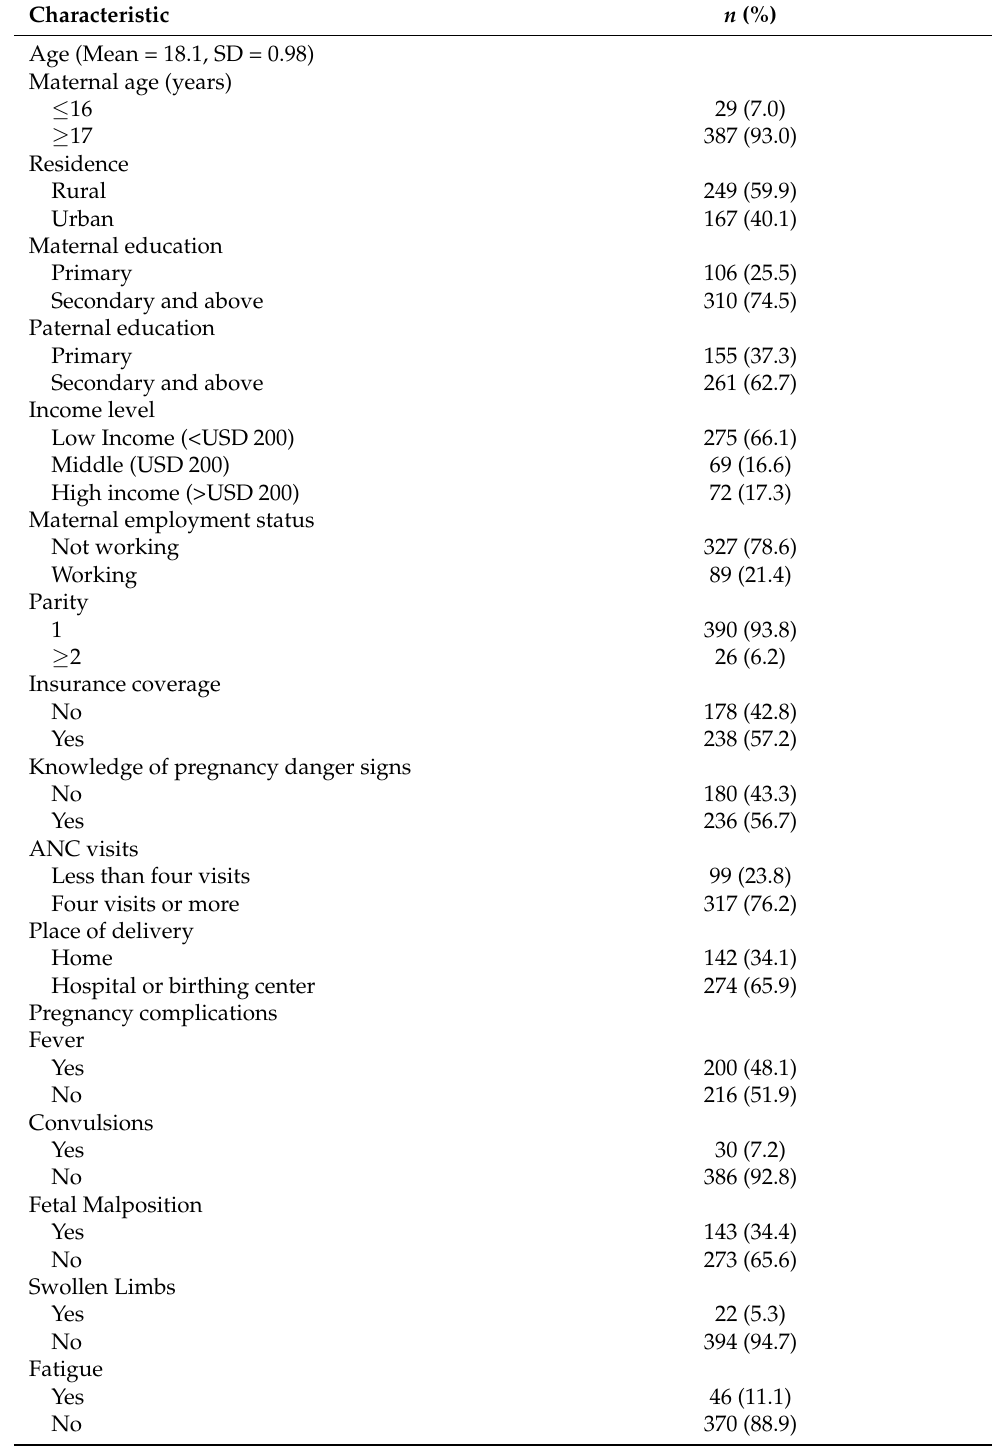
Table 1. Demographic characteristics of adolescent mothers ( n =